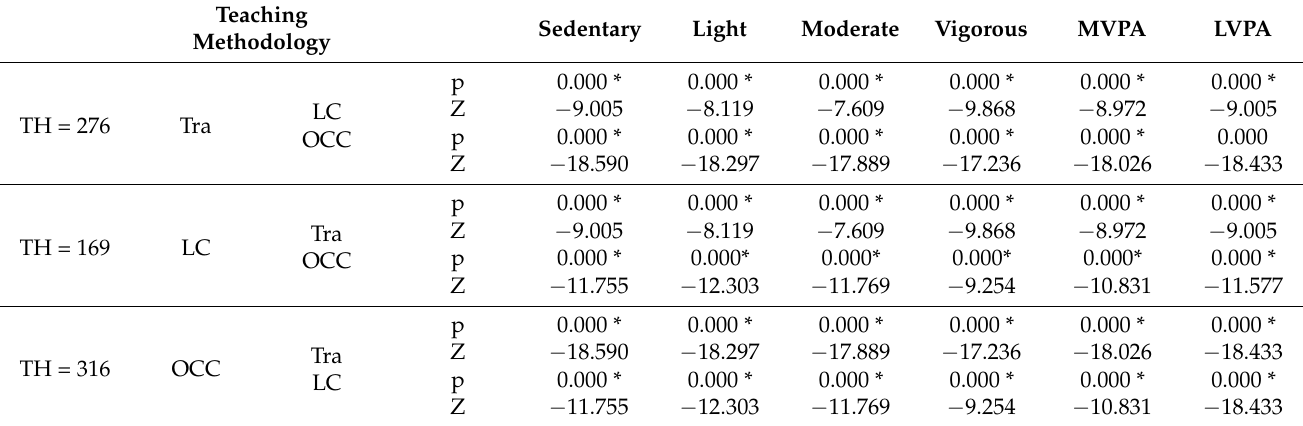
Table 4. Differences found among teaching methodologies and PA performed with different intensities. Teaching Sedentary Light Moderate Vigorous MVPA Methodology